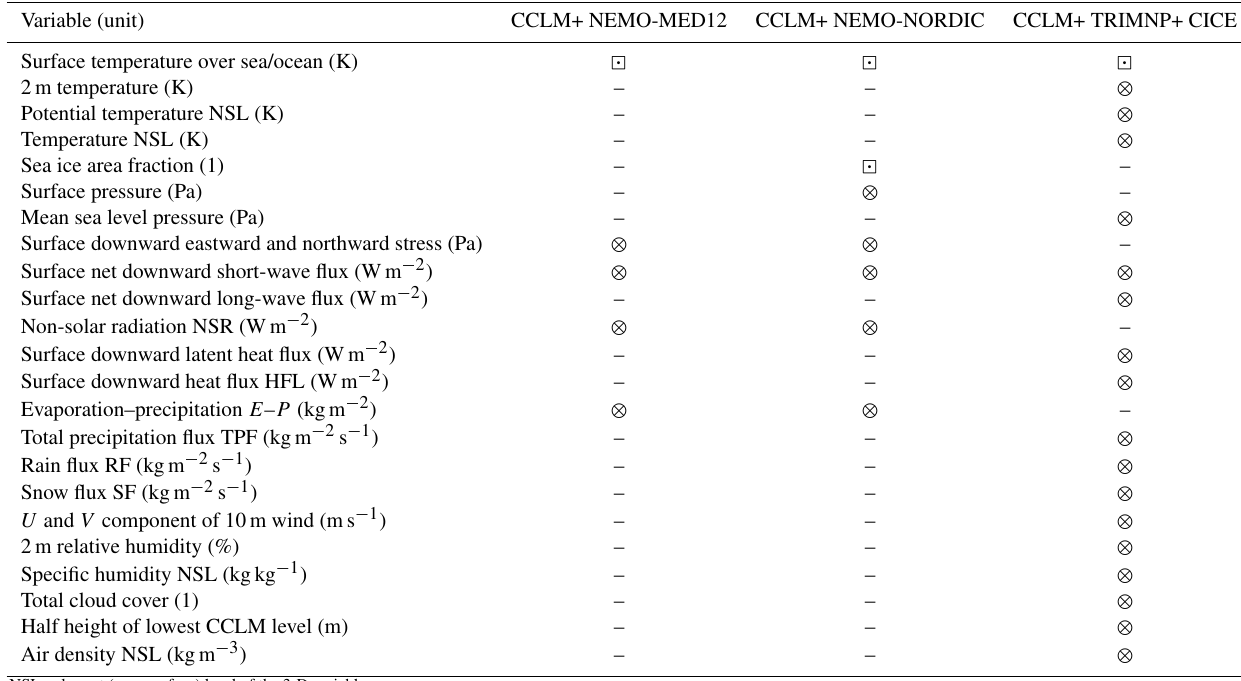
Table 5. As Table 4 but variables exchanged between CCLM and the NEMO, TRIMNP and CICE ocean models. Variable (unit) CCLM+ NEMO-MED12 Surface temperature over sea/ocean